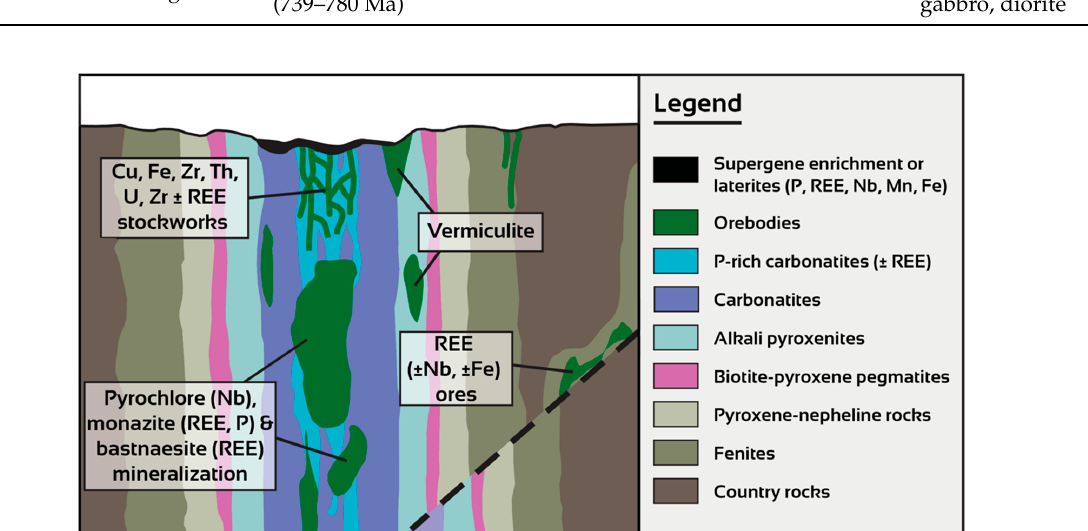
Figure 3. Geological cross-section of a hypothetical carbonatite–alkaline system and main related mineral deposits [53,59]. Not to scale.